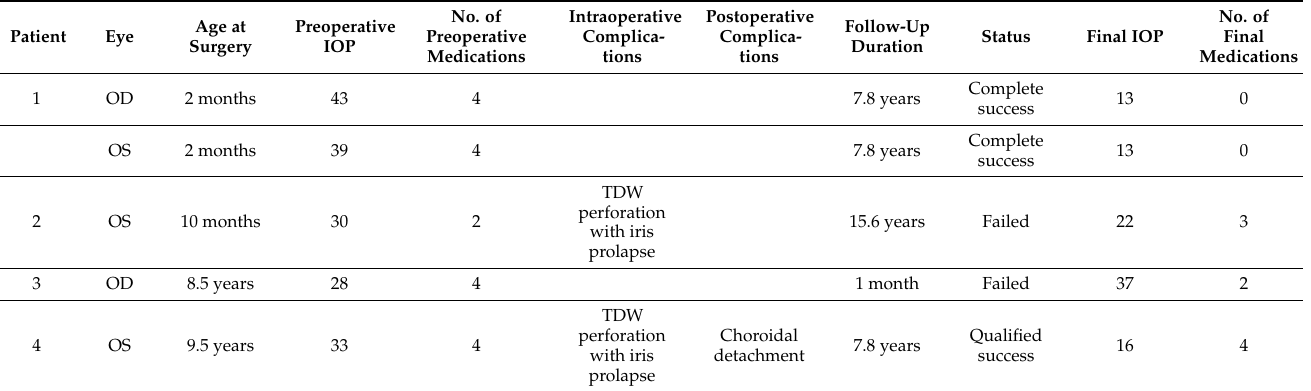
Table 1. Patient characteristics, complications, and